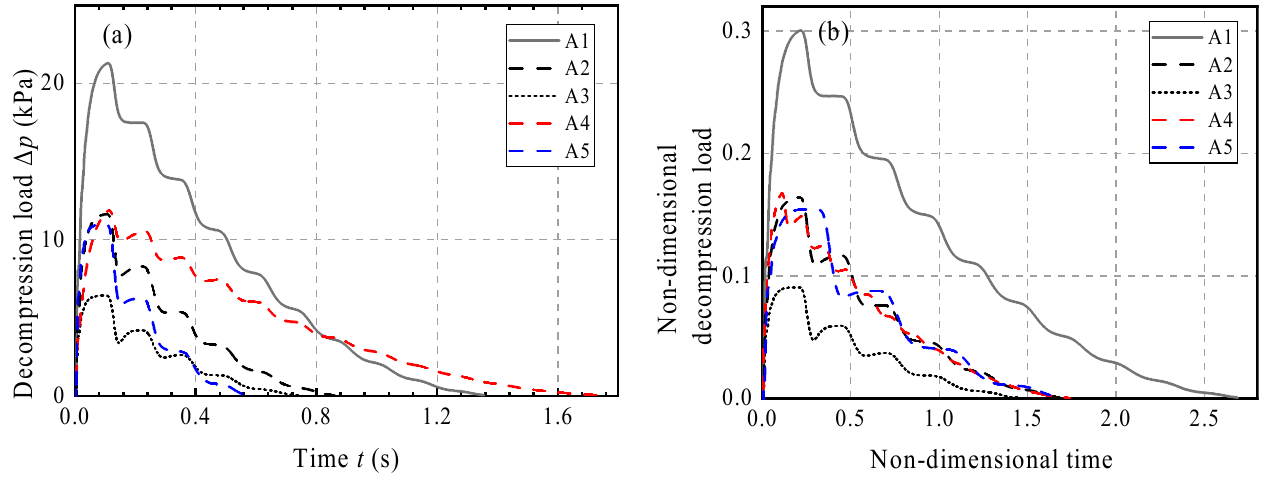
Figure 16. ( a ) Decompression load curves and ( b ) non-dimensional decompression load curves with windshield areas and decompression panel areas. Table 7. Varying windshield areas and decompression panel areas.